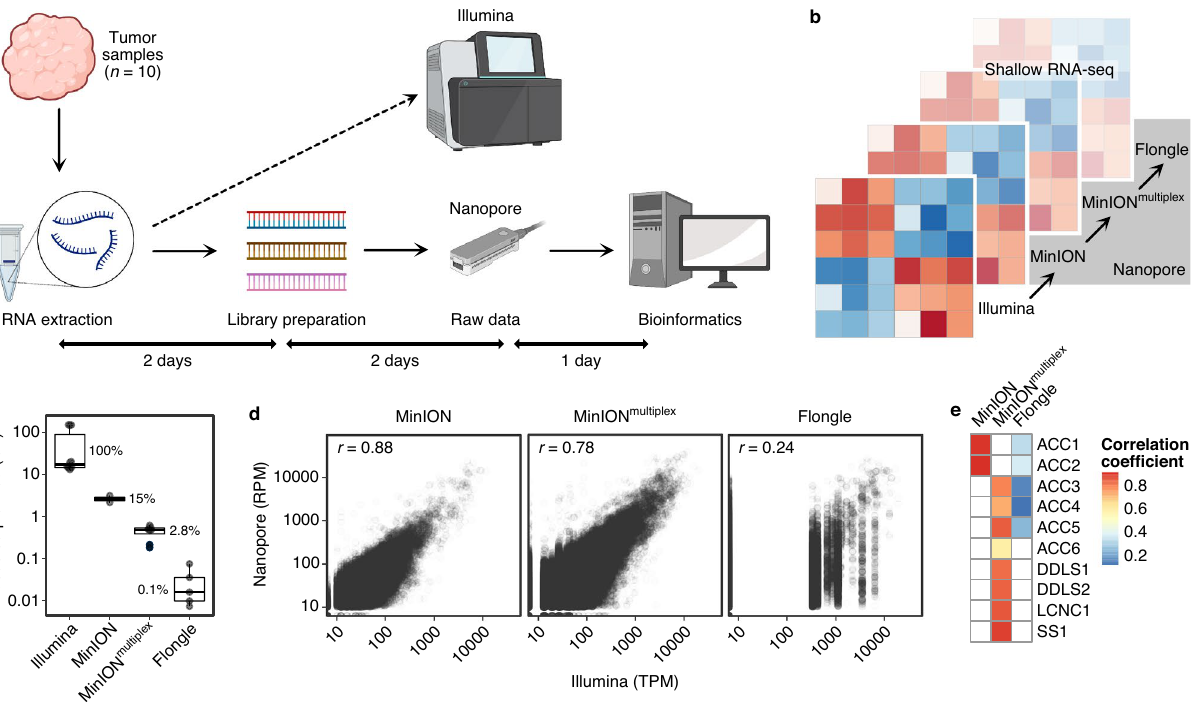
Figure 1. Comparison of shallow nanopore and Illumina RNA-seq. ( a ) Overview of sample and data processing for nanopore RNA-seq. Created with BioRender.com. ( b ) Schematic of the different sequencing depths used to perform nanopore RNA-seq (MinION flow cell with one sample, MinION flow cell with four samples [MinION multiplex ], Flongle flow cell with one sample). For illustration, transcriptomic profiling is depicted by a heatmap with increasing transparency representing decreasing sequencing depth. ( c ) Comparison of sequencing depth, i.e., bases sequenced, between technologies. Nanopore RNA-seq covered a median of 0.1–15% of the bases sequenced with Illumina RNA-seq. ( d ) Correlation of normalized gene-level counts obtained by nanopore (RPM values) and Illumina (TPM values) RNA-seq across all samples and protein-coding genes (Spearman rank correlation coefficient). Each dot represents a gene. ( e ) Correlation of normalized gene-level counts obtained by nanopore and Illumina RNA-seq for individual samples (Spearman rank correlation